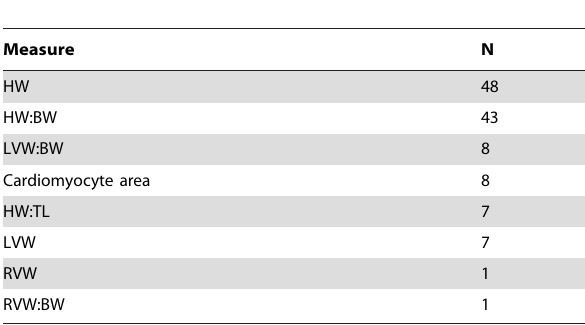
Measure indicates the value or index used to report cardiac hypertrophy. N indicates the number of studies that reported that measure. HW=heart weight; BW=body weight; TL=tibia length; LVW=left ventricle weight; RVW=right ventricle